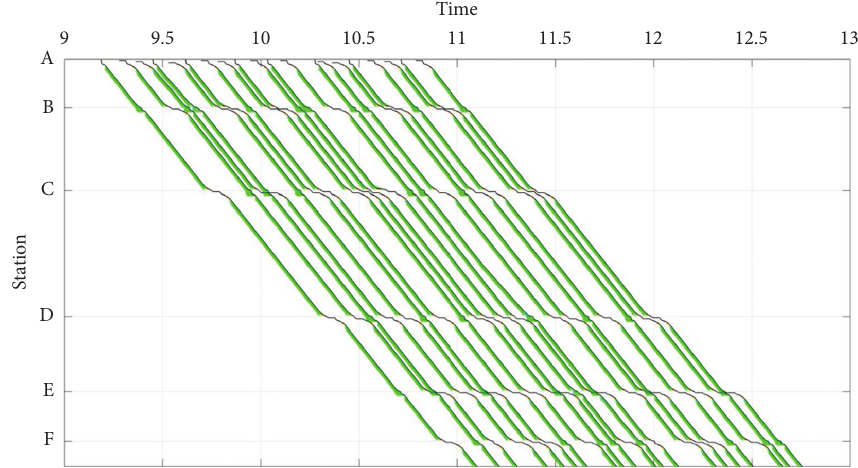
Figure 7: The planned timetable in the normal condition. Table 1: Train speed level and its running time. Speed